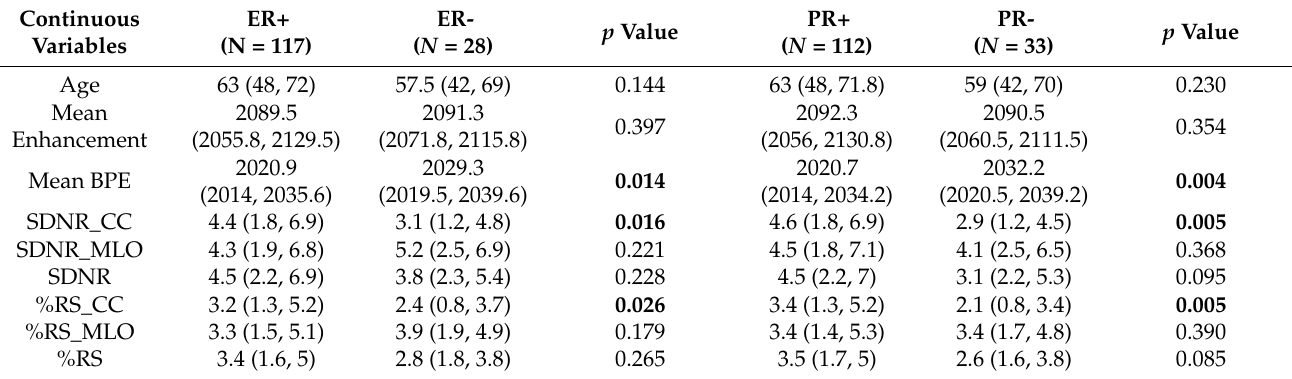
Table 2. Relation between CEM and ER and PR receptor status. Significant p values are in bold.